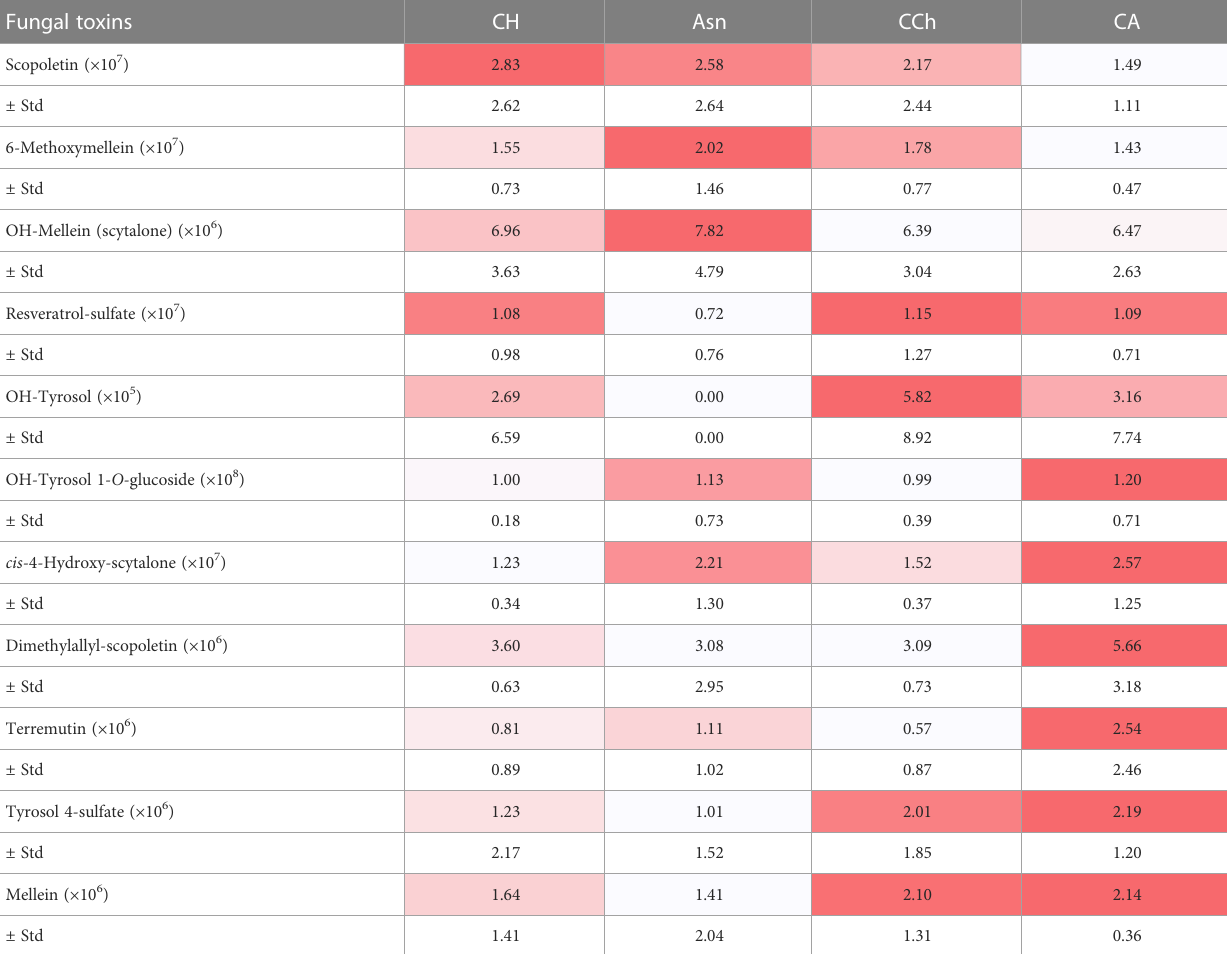
Colored gradient indicates intensities averaged levels (scale folds indicated in brackets). Std: standard deviation per wood sample group (CH: n=6, Asn: n=6; CCh: n=8 and CA: